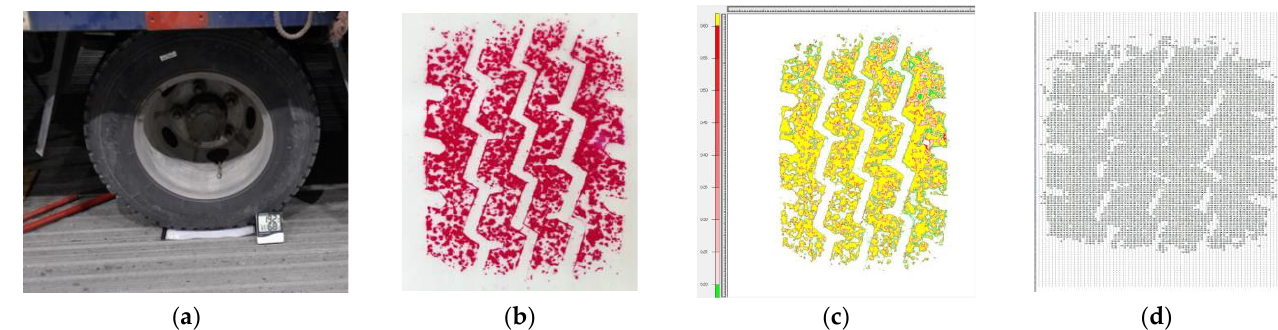
Figure 3. Schematics of pressure film operation process: ( a ) loading; ( b ) tire mark; ( c ) scanning image; ( d ) numerical statistics of contact stress.